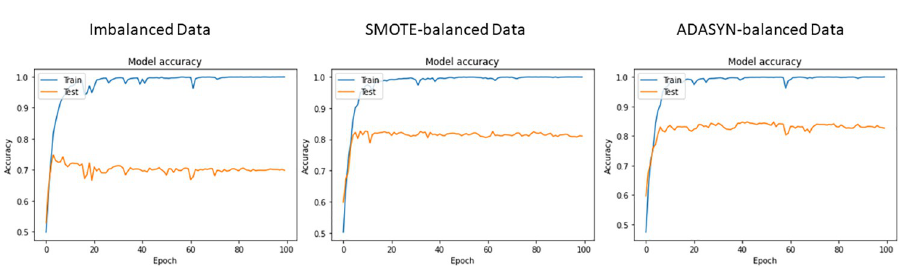
Fig 9. Accuracy measure of LSTM with respect to each epoch.